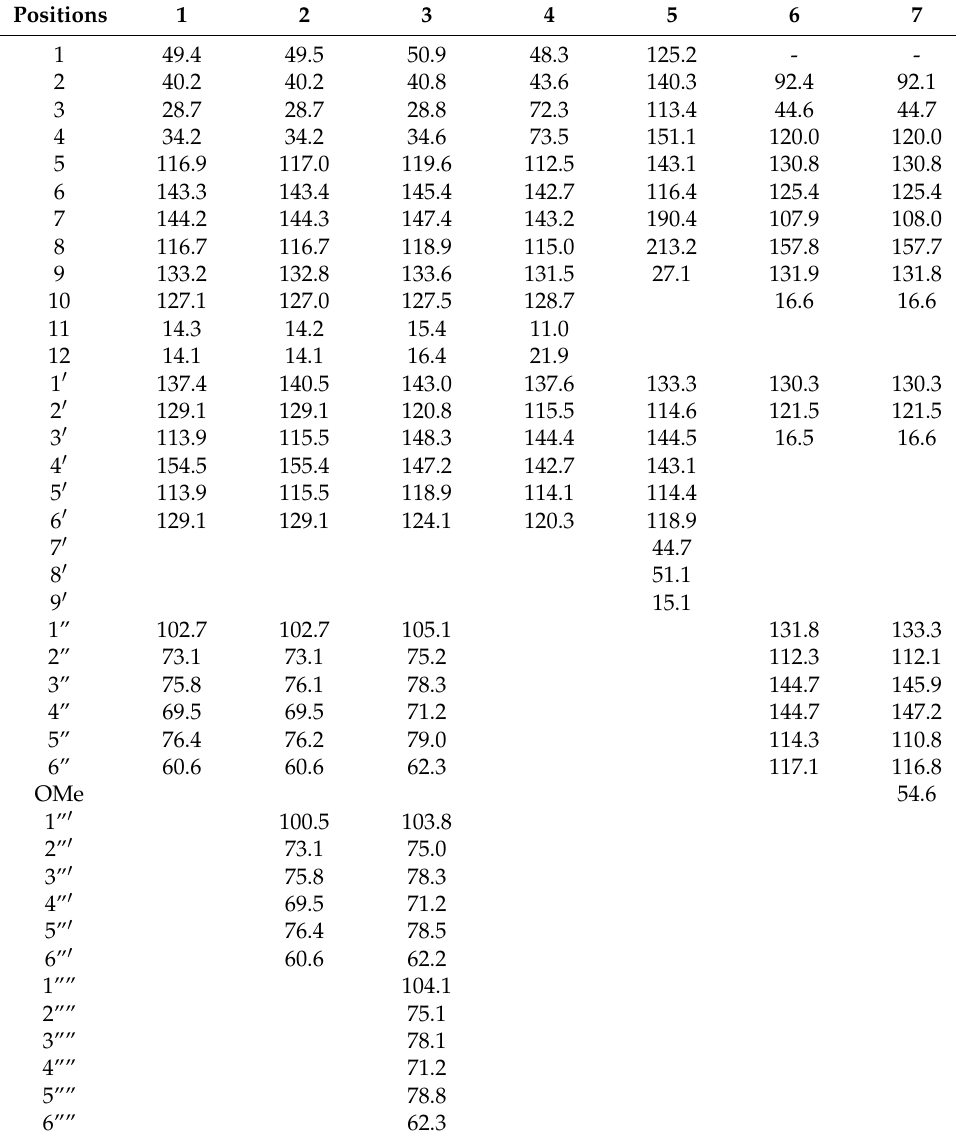
Table 3. 13 C-NMR spectral data for 1 – 7